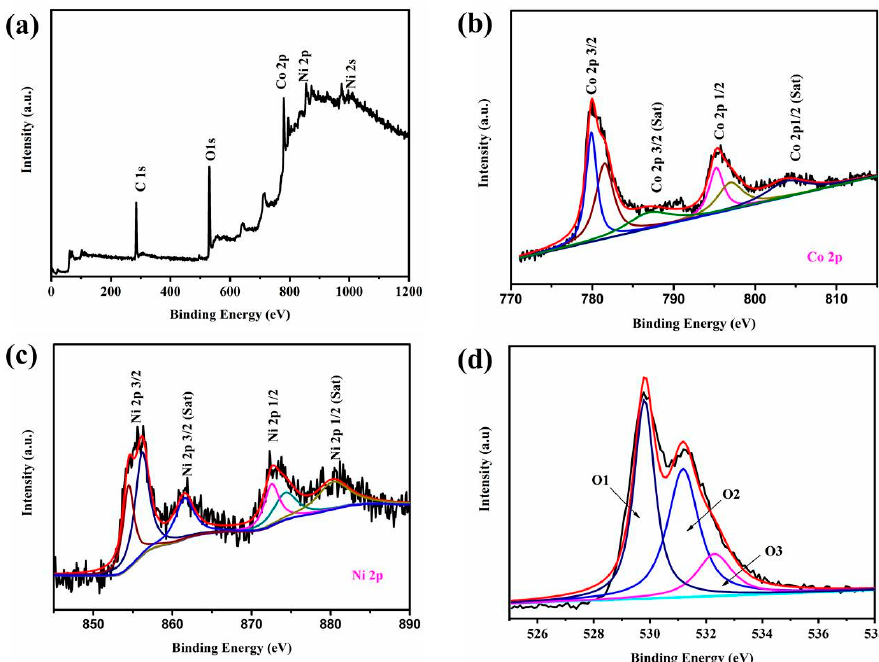
Figure 5. The XPS spectrum of core-shell NiCo 2 O 4 @NiCo 2 O 4 /NF composites ( a ) signals of Ni, Co, and O, ( b ) Co 2p spectra, ( c ) the major peak of nickel species, ( d ) O 1s spectrum. and O, ( b ) Co 2p spectra, ( c ) the major peak of nickel species, ( d ) O 1s